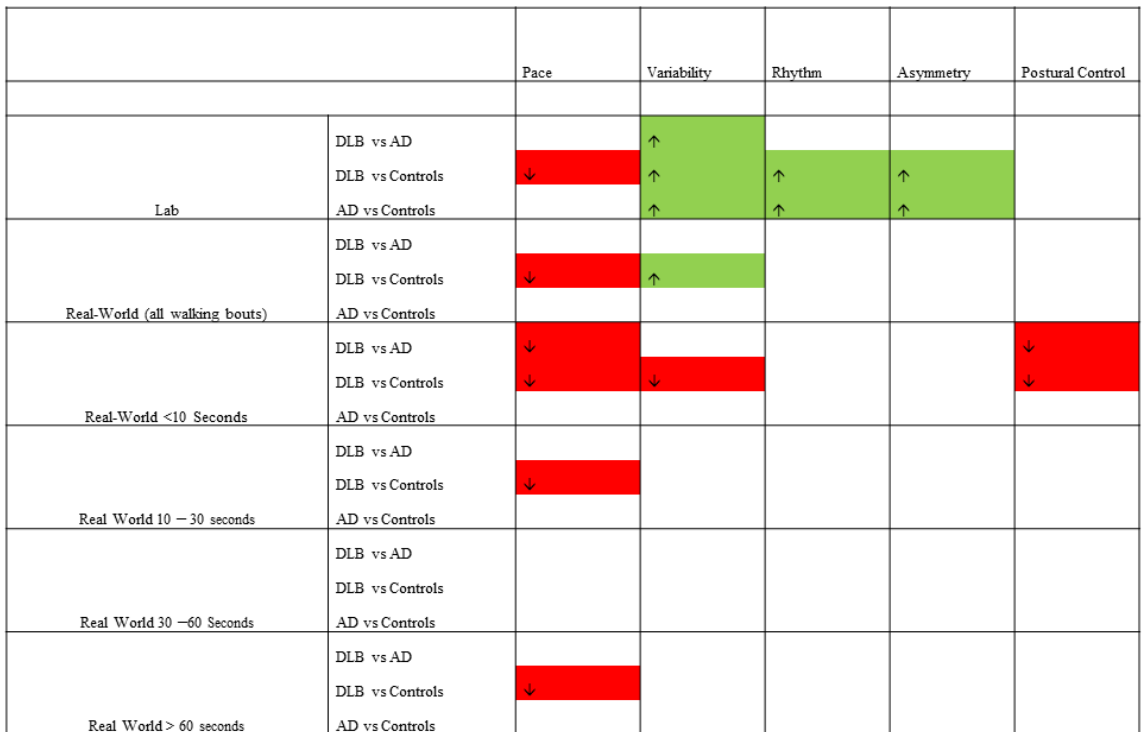
Figure 2. Gait impairments between groups across all conditions. Green = characteristic is significantly greater in the first group than the second. Red = characteristic is significantly less in the first group than the second.